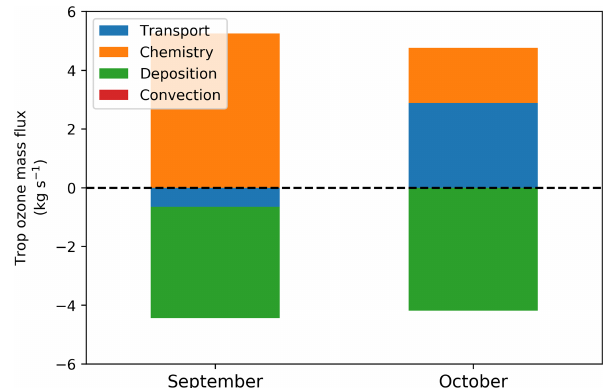
Figure 6. GEOS-Chem model mean tropospheric ozone mass fluxes (kg s − 1 ) over Southeast Asia in September and October 2014 av- eraged on the 2 ◦ × 2.5 ◦ global model grid. Fluxes are computed within GEOS-Chem and represent the difference in the model col- umn mass before and after each component is applied. The tropo- sphere is defined in this simulation using the dynamic tropopause height from GEOS-FP, which may not precisely correspond to the tropospheric columns defined in Sect.